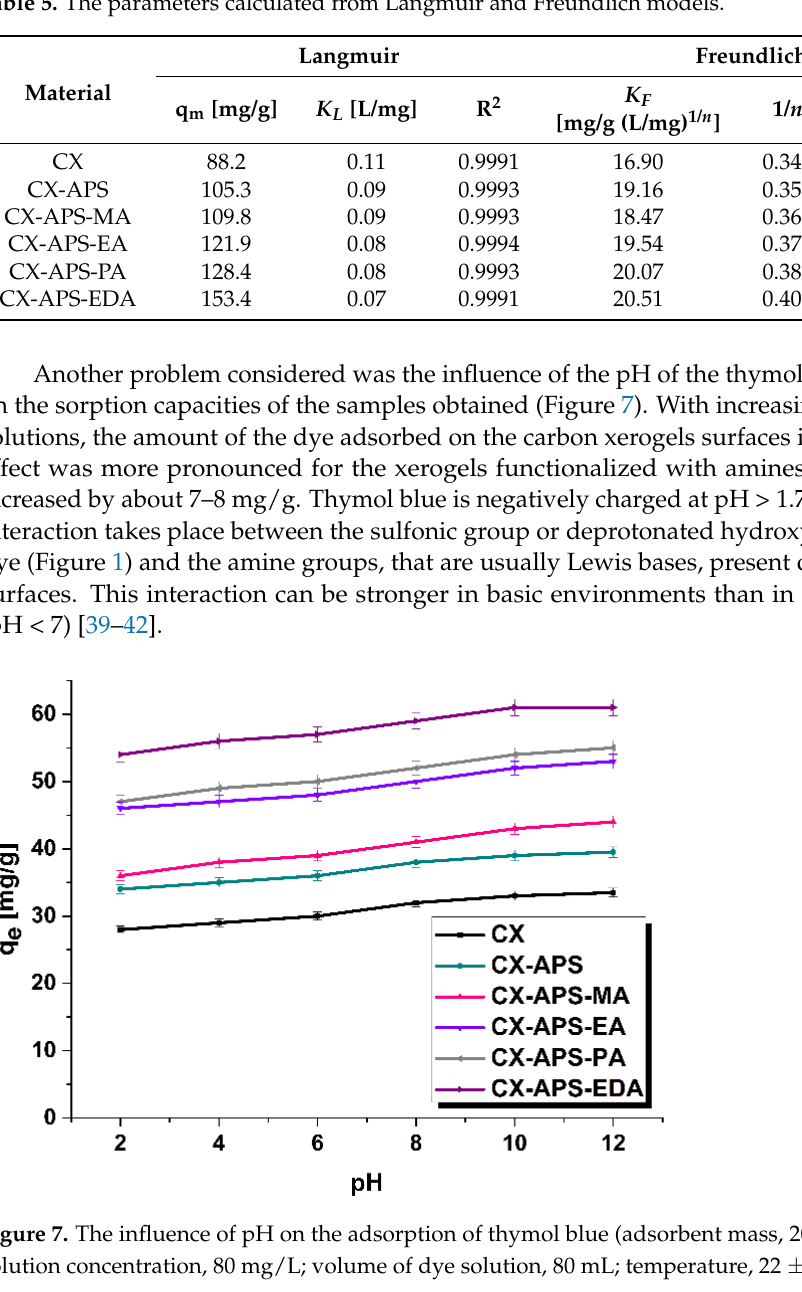
Table 5. The parameters calculated from Langmuir and Freundlich models.